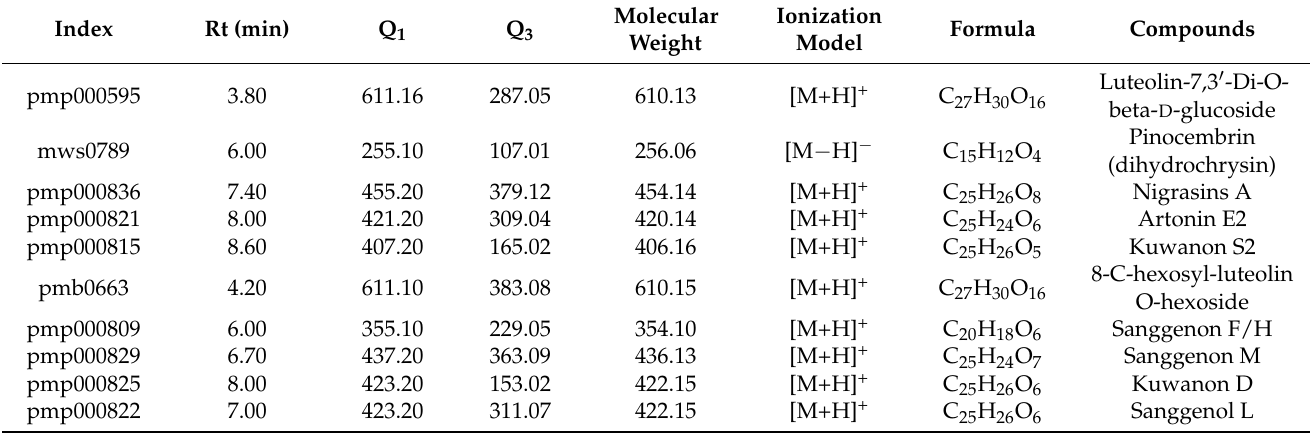
Figure 7. KEGG enrichment of differential metabolites. ( a )–( c ) KEGG classification of the differential metabolites in com- parison group CSG versus CHG, CSG versus CFG and CHG versus CFG. Table 1. List of biologically active, upregulated flavonoid metabolites detected in CSG. Index